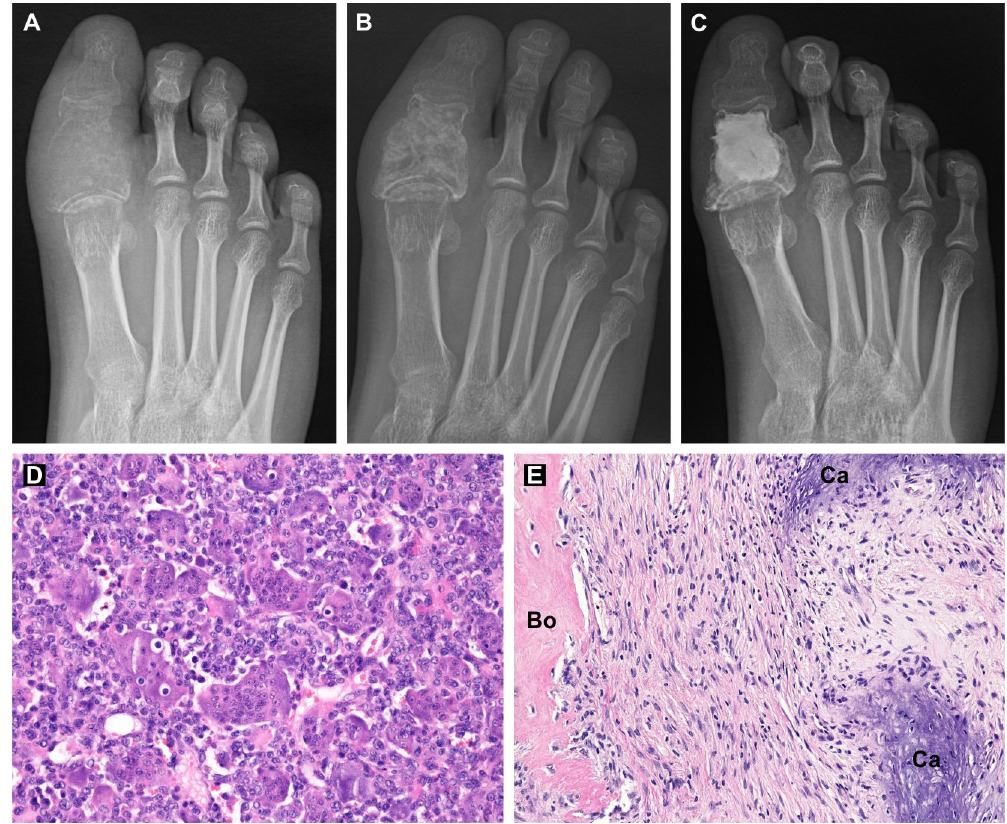
Figure 7. X-ray images of the patient’s right big toe during the treatment: before treatment ( A ), one month after combination treatment with denosumab and sunitinib ( B ) and after curettage and bone cavity filling with bone cement ( C ). Hematoxylin-eosin-stained sections of GCTB tissue before treatment ( D ) and after combination treatment with denosumab and sunitinib ( E ). Regions of bone tissue (Bo) and calcifications (Ca) are labeled. Original magnification, 200× ( D , E ).